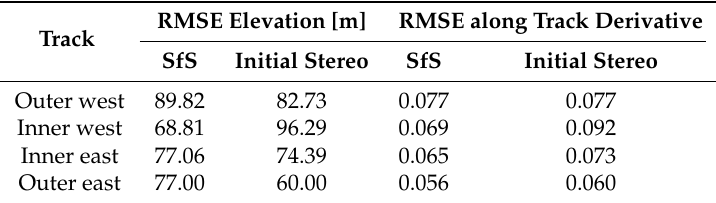
Table 8. RMSE of the elevation (Figure 17) and the first derivative (Figure 18) along the tracks in Figure 16b calculated for the SfS DTM and the initial Stereo DTM.